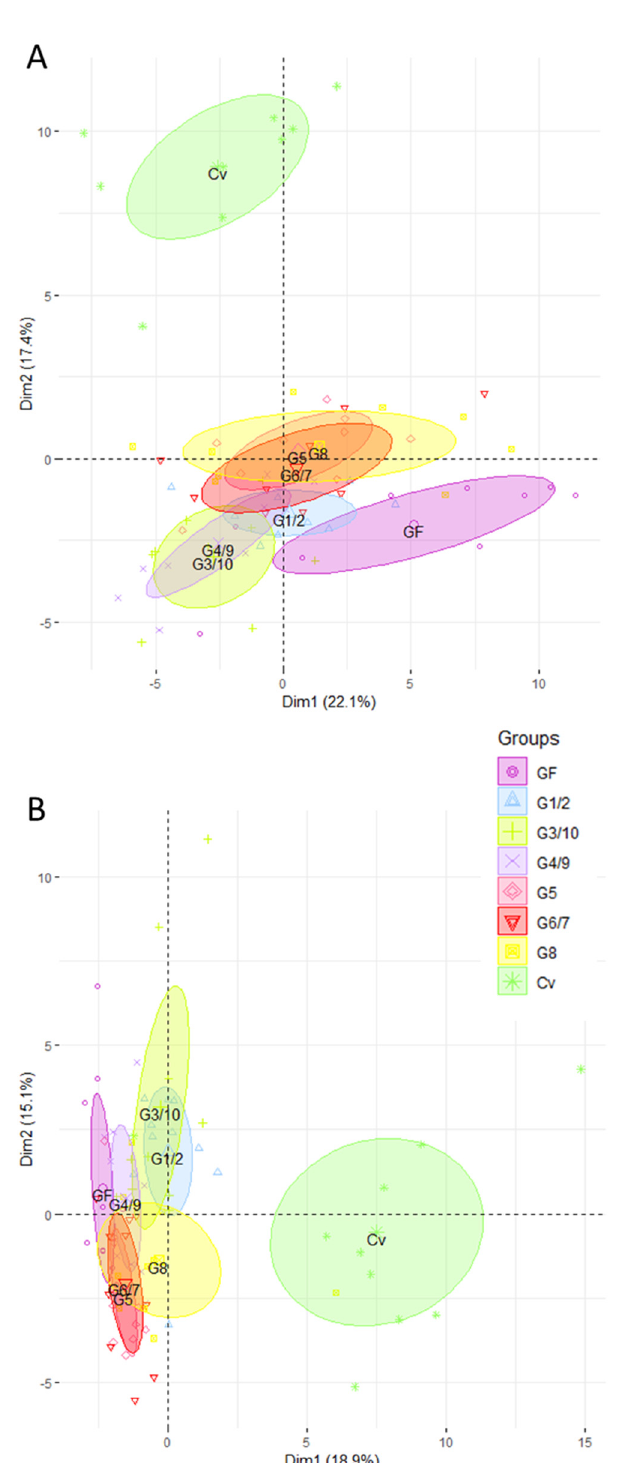
Figure 4. The intestinal gene expression profiles of mono-associated mice converge toward the CV profile. Ileal ( A ) and colonic ( B ) gene expression was analyzed in mice mono-associated with one of the six Symbioflor2 ® genotypes (G1/2, G3/10, G4/9, G5, G6/7, G8), in CV and in GF mice. Rq values that represent the abundance of transcripts relative to GF group were used for PCA analysis after trimming datasets for the least informative genes. In total, 84 genes were retained for PCA in the ileum and 60 in the colon; n = 10 for each group of mice.